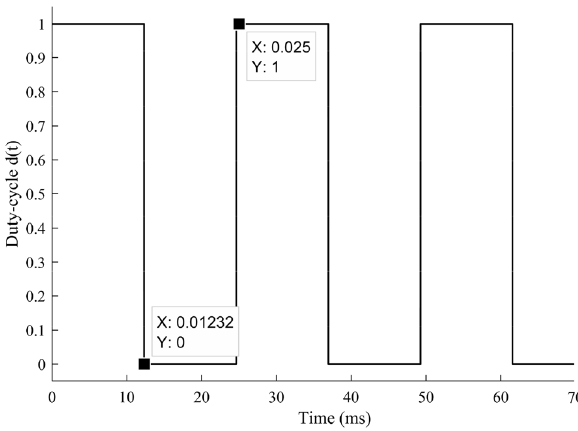
Figure 11. PWM duty-cycle d ( t ) , output of RCC unit.